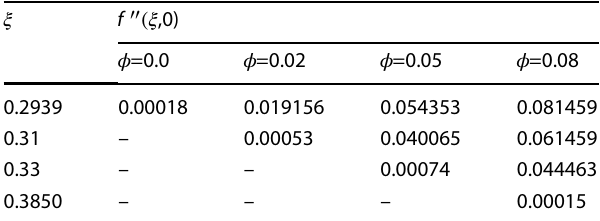
Table 7 Effect of 𝜙 and 𝜉 on f �� ( 𝜉 ,0 ) profile near separation point ( 𝜆 < 0 ) for fixed Pr =6.7